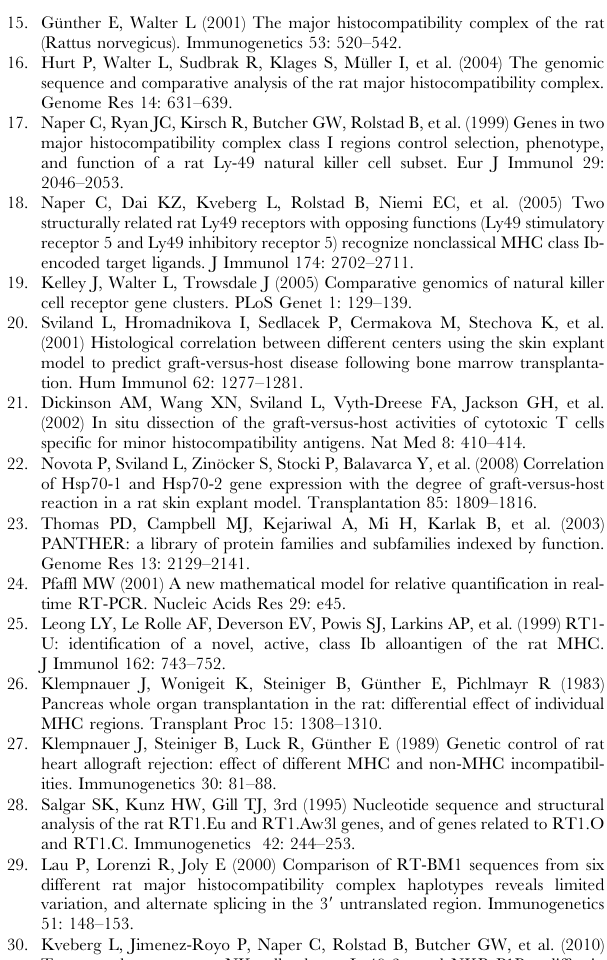
Table S4 Primer sequences used for mRNA expression